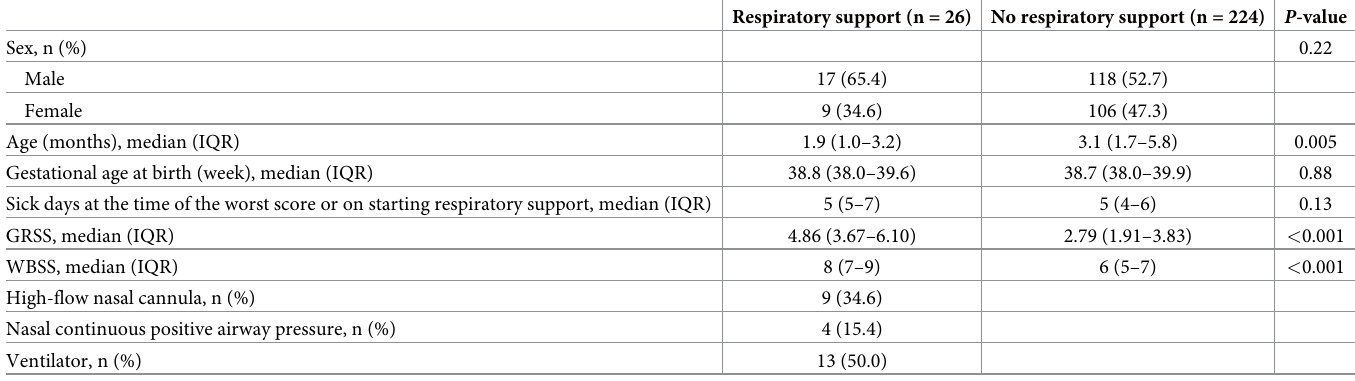
Table 2. Baseline characteristics of the study